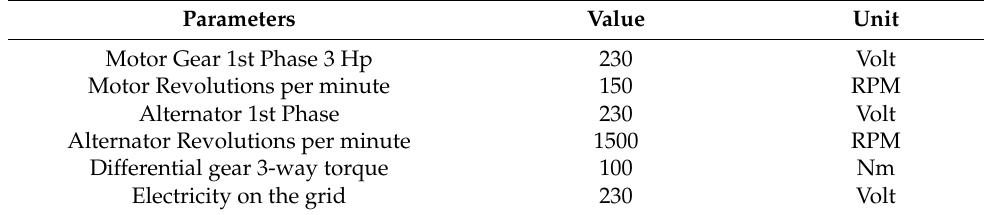
Table 2. High-torque technology for driving motors and